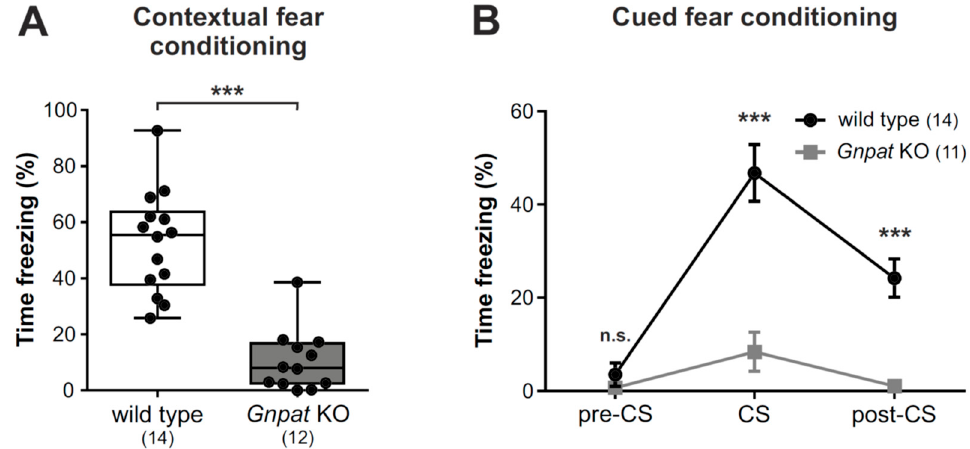
Figure 6. Fear conditioning reveals considerable impairments in contextual and cue learning upon ether lipid deficiency: ( A ) The contextual fear conditioning paradigm was applied to WT and Gnpat KO mice, and the duration of the freezing response is shown as box plot, with whiskers indicating minimal and maximal values. Statistical analysis was performed using two-tailed Student’s t -test. ( B ) WT and Gnpat KO mice were exposed to the cued fear conditioning paradigm, and the duration of the freezing response was quantified before (“pre-CS”), during (“CS”), and after (“post-CS”) the conditioned stimulus (CS). Data are shown as mean ± SEM, and statistical analysis was performed using Mann–Whitney U tests with Bonferroni correction for the repeated measurements. The number of tested animals is given in brackets. The findings displayed in Figure 6A have been published previously with a smaller cohort of WT and Gnpat KO mice [11]. *** p < 0.001; n.s. , not significant .